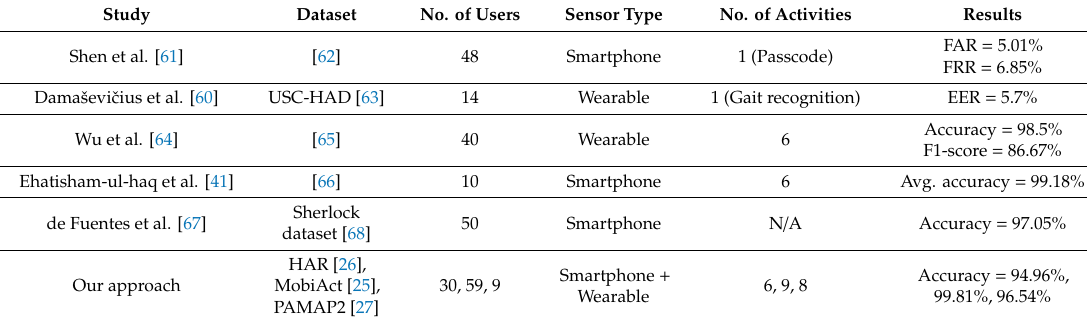
Table 7. Comparisons of previous work-related continuous authentication with our